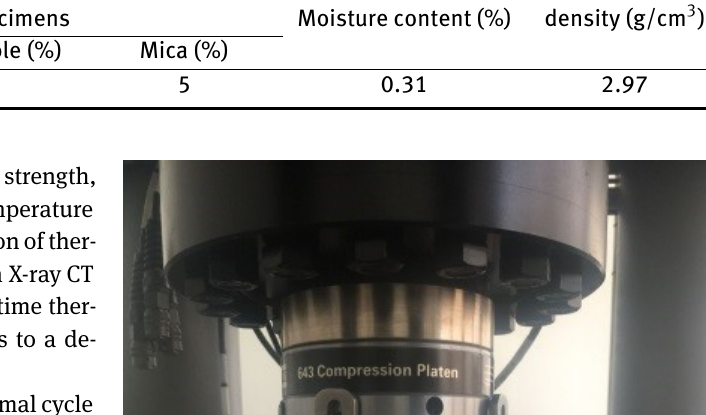
Table 1: Mineral composition and physical properties of granite specimens that were tested Mineral composition of specimens